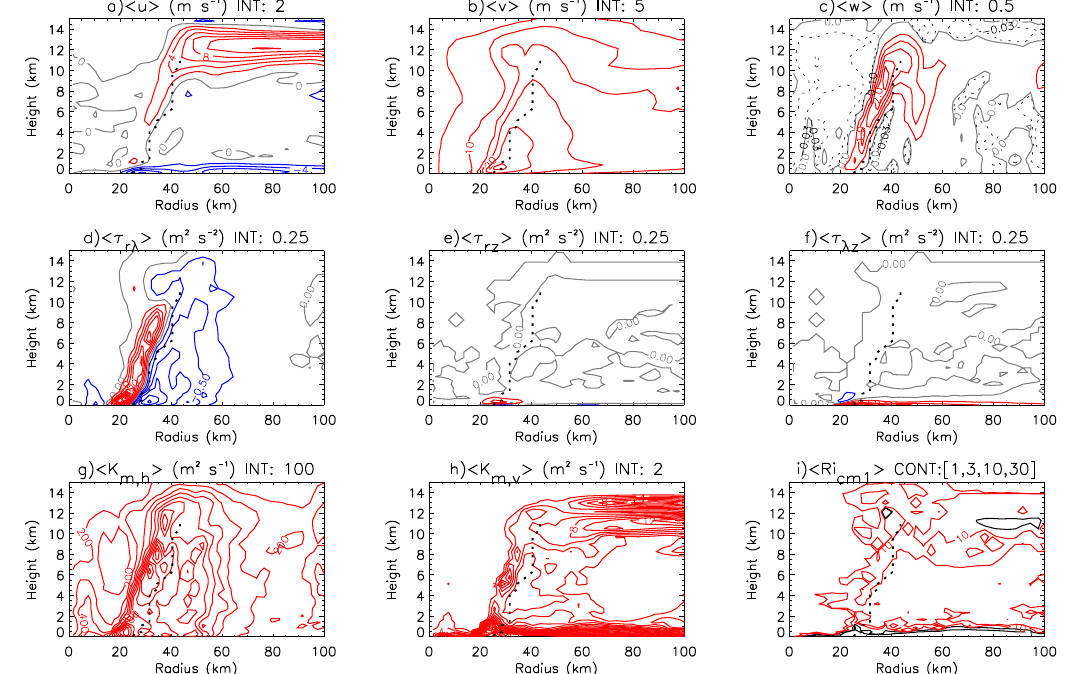
Fig. 16. Radius-height contour plots of resolved and subgrid eddy momentum fluxes and related quantities from the AX3k simulation using data at a 2-minute interval and averaged over the interval of maximum intensification rate (77 - 83 h). Except where otherwise noted, there is a maximum of 20 positive red contours and 20 negative blue contours. Panel (a): h u i with contour interval 2 m s − 1 ; panel (b): h v i with contour interval 5 m s − 1 ; panel (c): h w i with contour interval 0.5 m s − 1 ; panel (d): subgrid momentum flux corresponding to Fig. 14d h τ rλ i with contour interval 0.25 m 2 s − 2 ; panel (e): subgrid momentum flux corresponding to Fig. 14e h τ rz i with contour interval 0.25 m 2 s − 2 ; panel (f): subgrid momentum flux corresponding to Fig. 14f h τ λz i with contour interval 0.25 m 2 s − 2 ; panel (g): horizontal diffusivity h K m,h i with contour interval 100 m 2 s − 1 ; panel (h): vertical diffusivity h K m,v i with contour interval 2 m 2 s − 1 ; panel (i): time and axisymmetric average of the gradient Richardson number used in the CM1 model h Ri cm 1 i with black contours 1 and 3 and red contours 10 and 30. The radius of maximum h v i at each height is shown with the black dashed curve (up to 11 km).